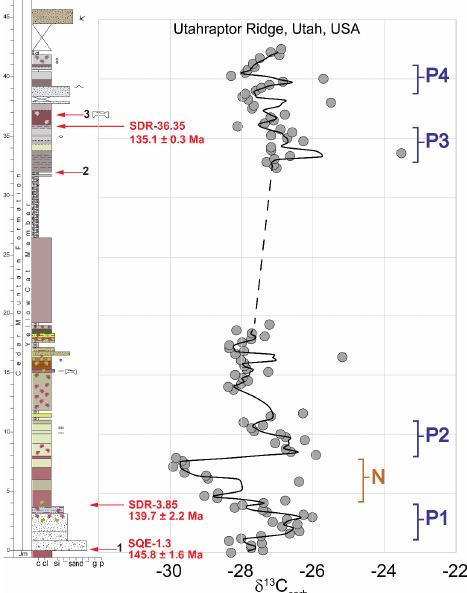
Figure 5. The δ 13 C chemostratigraphic profile (trend line is a smoothed 3-point moving average) from Yellow Cat Member, overlying Jurassic Morrison Formation (Jm) at Utahraptor Ridge. The stratigraphic position of a new high-precision eruption age of cryptotephra from sample SDR-36.35, as well as those of other published LA-ICP-MS concordia ages are shown in red; sample gap indicated by dashed line. “P” denotes positive δ 13 C features on the 3-point moving average curve described in text and “N” denotes a prominent negative feature. See Figure 1 and text for details. Raw data are presented in Table 1.